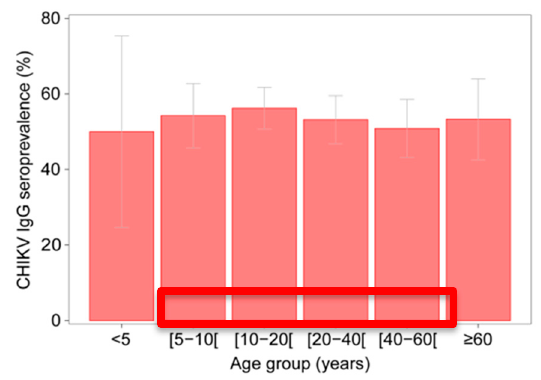
Figure 2. Seroprevalence by age group and exact binomial 95% confidence intervals.